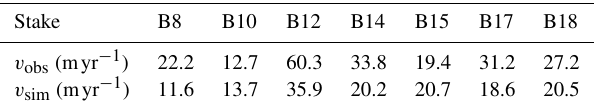
Table 1. Comparison between simulated and observed velocities at stakes where velocity observations are available from Geoestudios (2013).